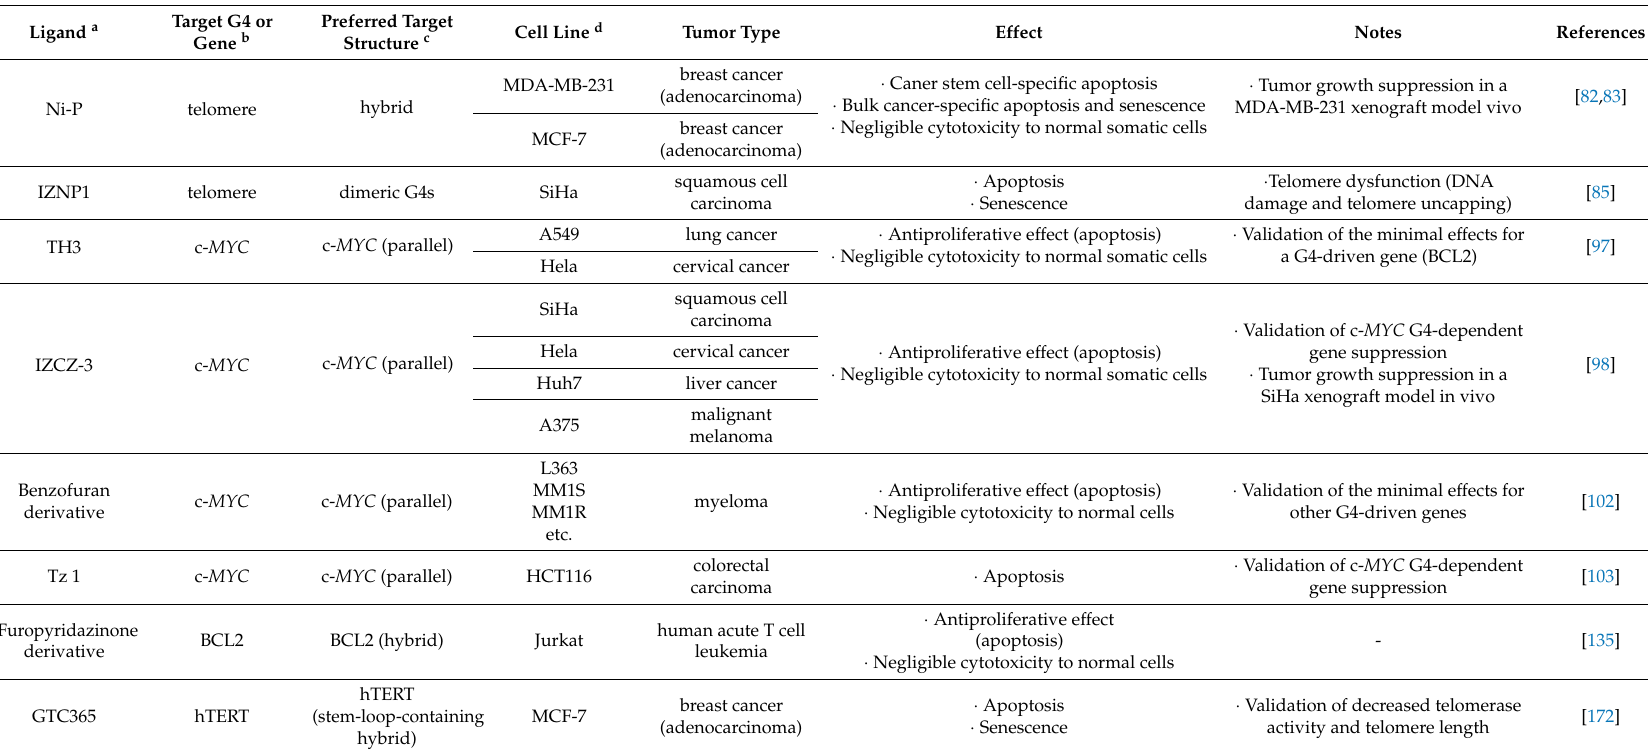
Table 1. Summary of targeted G-quadruplex (G4)-preferred ligands that exhibit antitumor